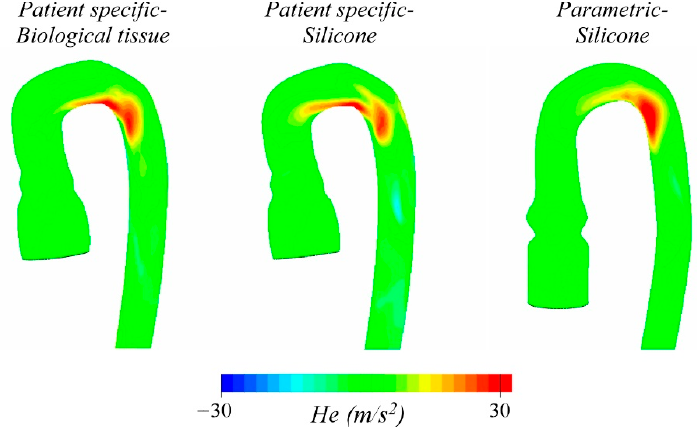
Figure 9. Helicity field computed for the three models at the time t/T =